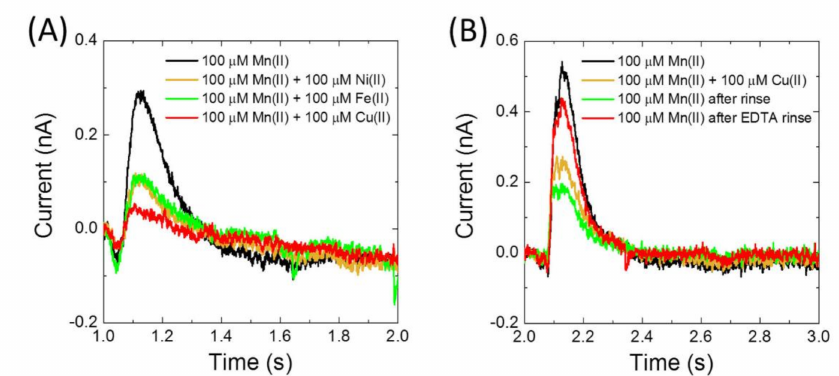
Figure 5. ( A ) Electrophysiology experiments of his-tagged MntH2 proteoliposomes (LPR 10:1 ( w / w )) in 10 mM HEPES, pH 8.0, 150 mM NaCl, 2 mM MgCl 2 . Between 1 and 2 s, 100 µ M MnCl 2 was used to initiate uptake either without other metals or together with 100 µ M of Fe(II), Ni(II) or Cu(II) as indicated. ( B ) Same as ( A ), but metal uptake of Mn(II) was initiated between 2 and 3 s in the absence and then presence of 100 µ M of Cu(II). After exposing MntH2 to Cu(II), the sensor cell was rinsed intensively with bu ff er, but Mn(II) uptake was not recovered, unless the cell was rinsed with 10 mM EDTA